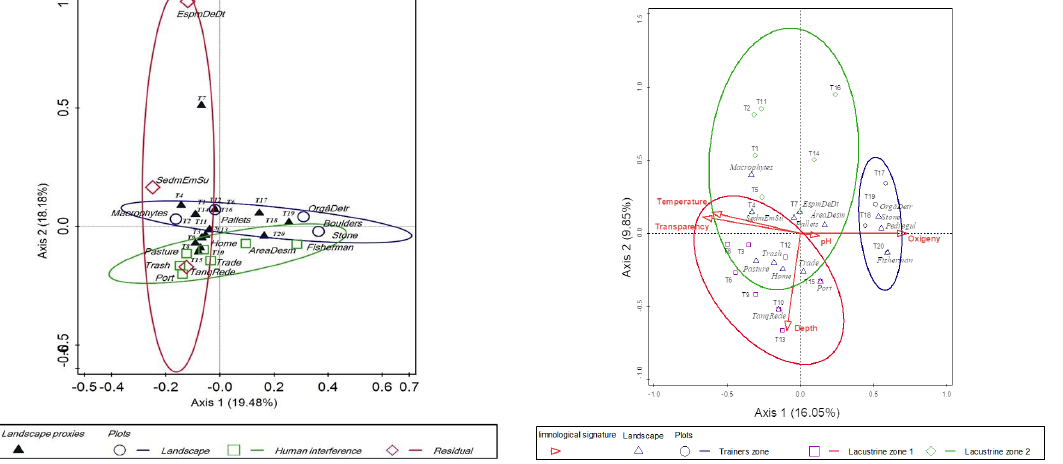
Figure 4. Ordering Diagram of the Correspondence Analysis (CA) of the qualitative variables of the landscape distributed in 20 transects along the Curuá-Una reservoir, in November, 2016. Legend: T = Transects; SedmEmSu = Suspended sediment; TanqRede = Cage fish farming; Area Desm = Deforested area; OrgâDetr = Organic matter/debris; EspDeDet = Foam from household detergent.